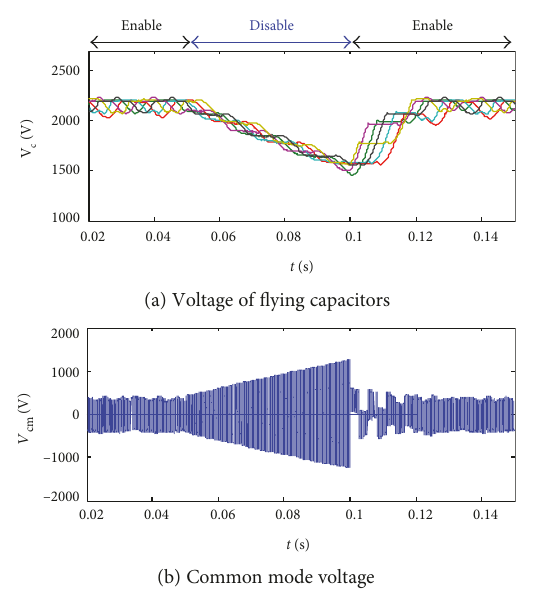
Figure 9: Simulation results with and without capacitor balancing